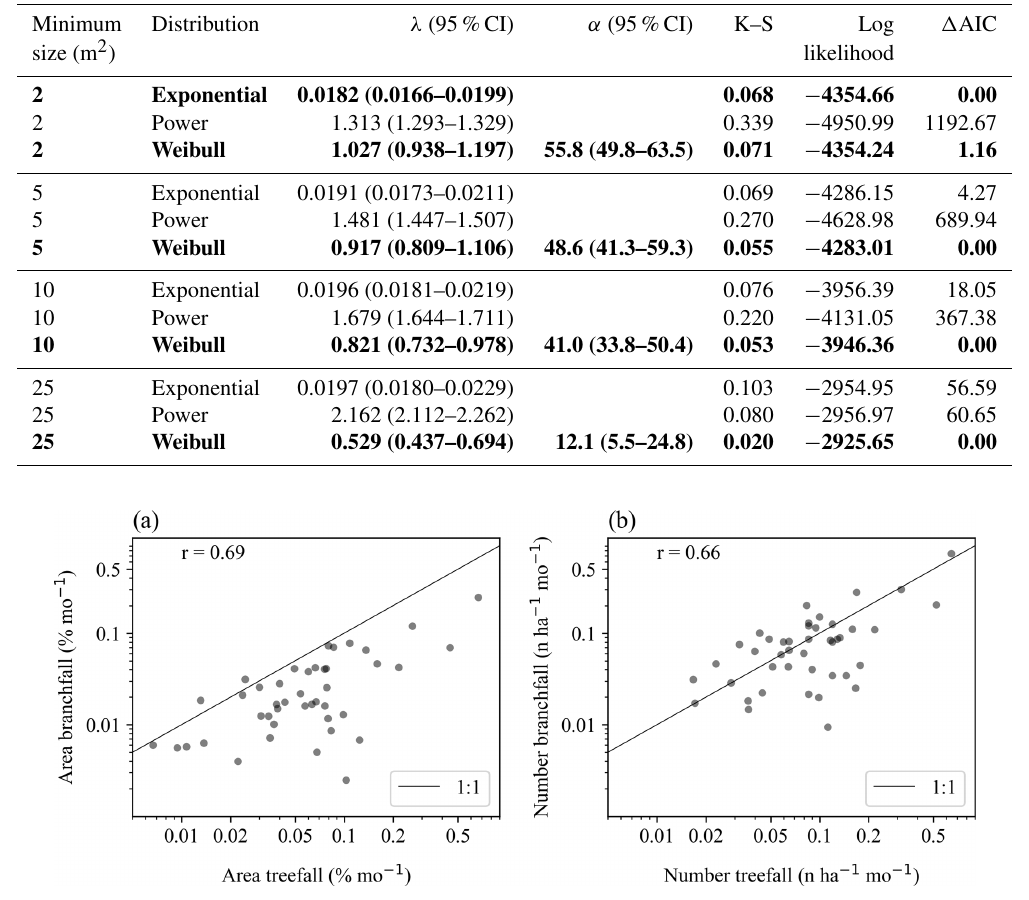
Figure 7. Relationship of temporal variation in branchfall rates to temporal variation in treefall rates, when measured by total area (a) and number of events (b) . The 1 : 1 line is shown for